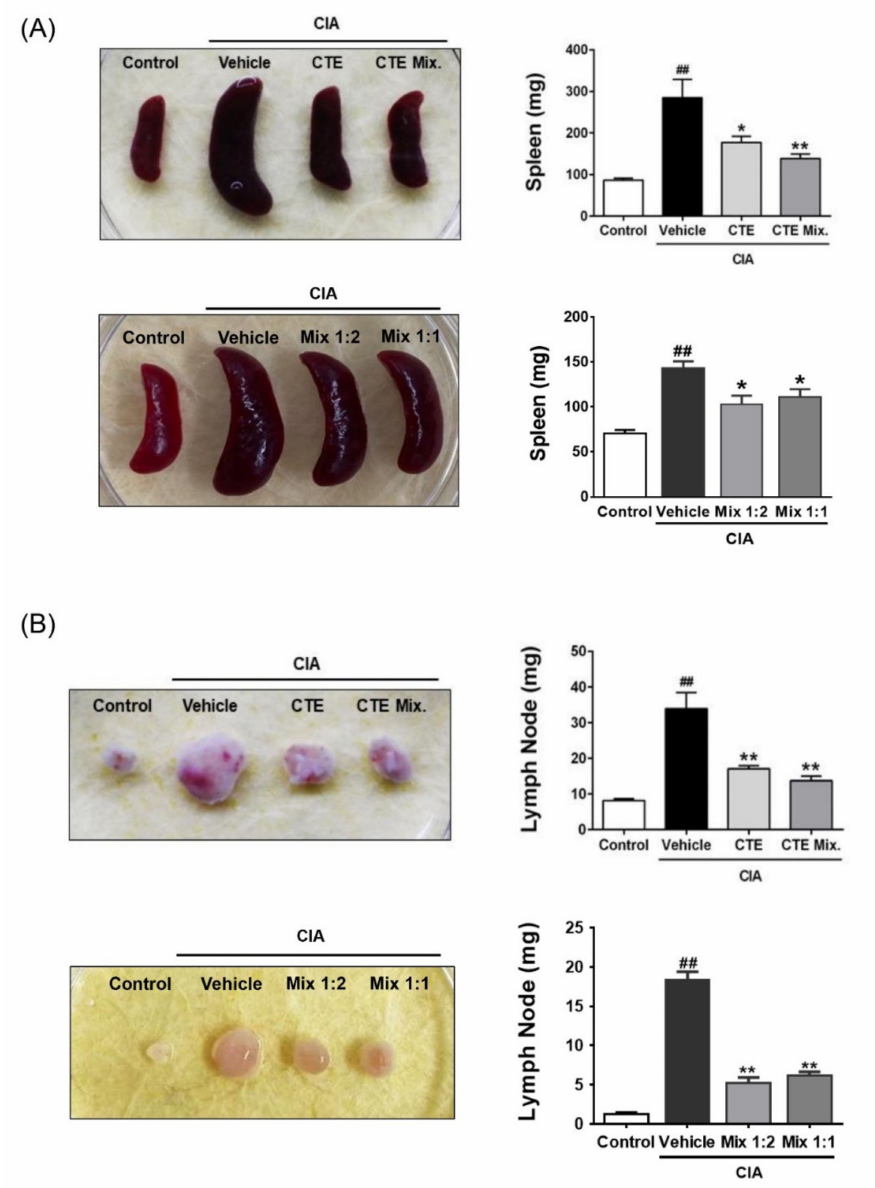
Figure 5. Effect of CTE and CTE mix immune responses in CIA-induced animal model. ( A ) The control group and vehicle group were orally administered physiological saline. In the CTE group, only CTE was administered orally, while in the CTE/SKE combination groups, these extracts were mixed at the respective concentrations of 2:1, 1:2, and 1:1 and administered orally. A comparative analysis of spleen size and weight according to group was then performed (control vs. ## p < 0.01; vehicle vs. * p < 0.05, ** p < 0.01; n = 5). ( B ) The control group and vehicle group were orally administered physiological saline. In the CTE group, only CTE was administered orally, while in the CTE/SKE combination groups, these extracts were mixed at the respective concentrations of 2:1, 1:2, and 1:1 and administered orally. A comparative analysis of lymph node size and weight by according to group was then performed (control vs. ## p < 0.01; vehicle vs. * p < 0.05, ** p < 0.01; n =